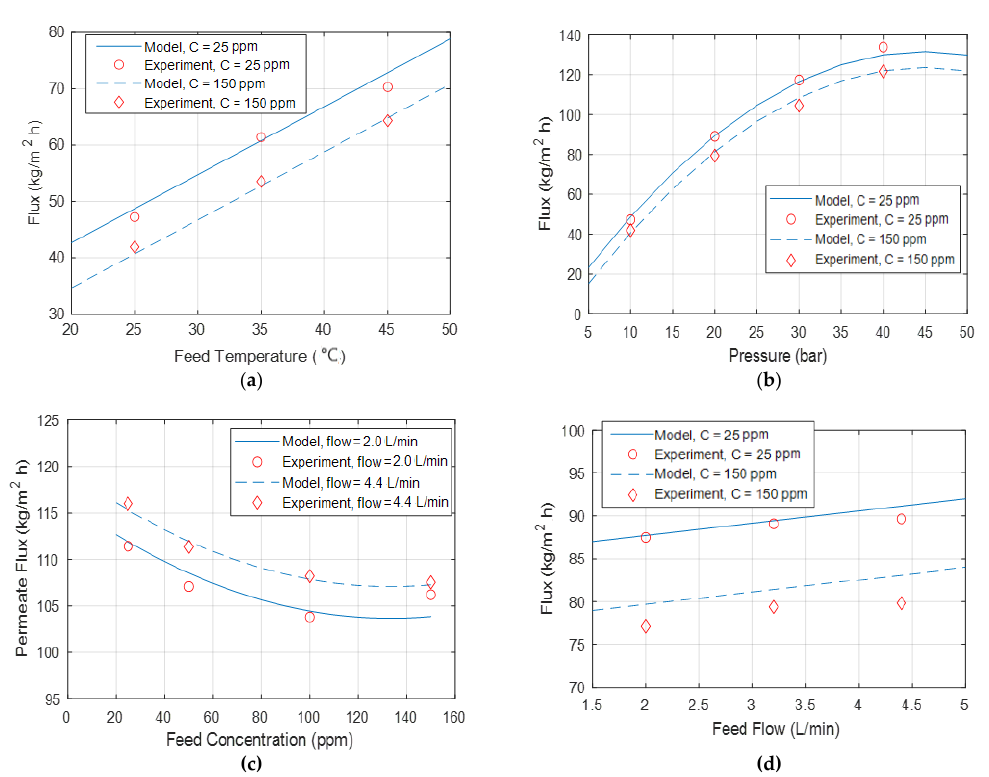
Figure 7. Permeate flux comparative presentation between experimentally obtained and modeled data under different ( a ) temperatures, ( b ) pressures, ( c ) concentrations, and ( d ) flow rates.